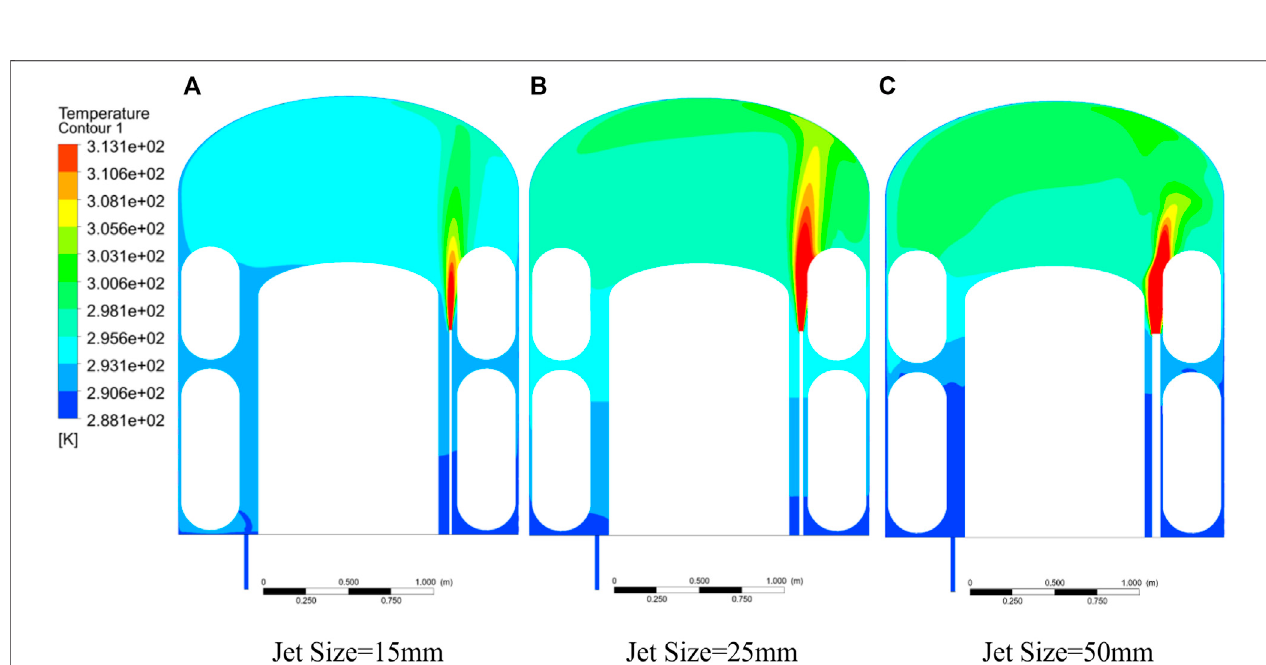
Figure 12A . The core region of Figure 12C is small because the velocity is too small to transfer heat far in vertical direction.